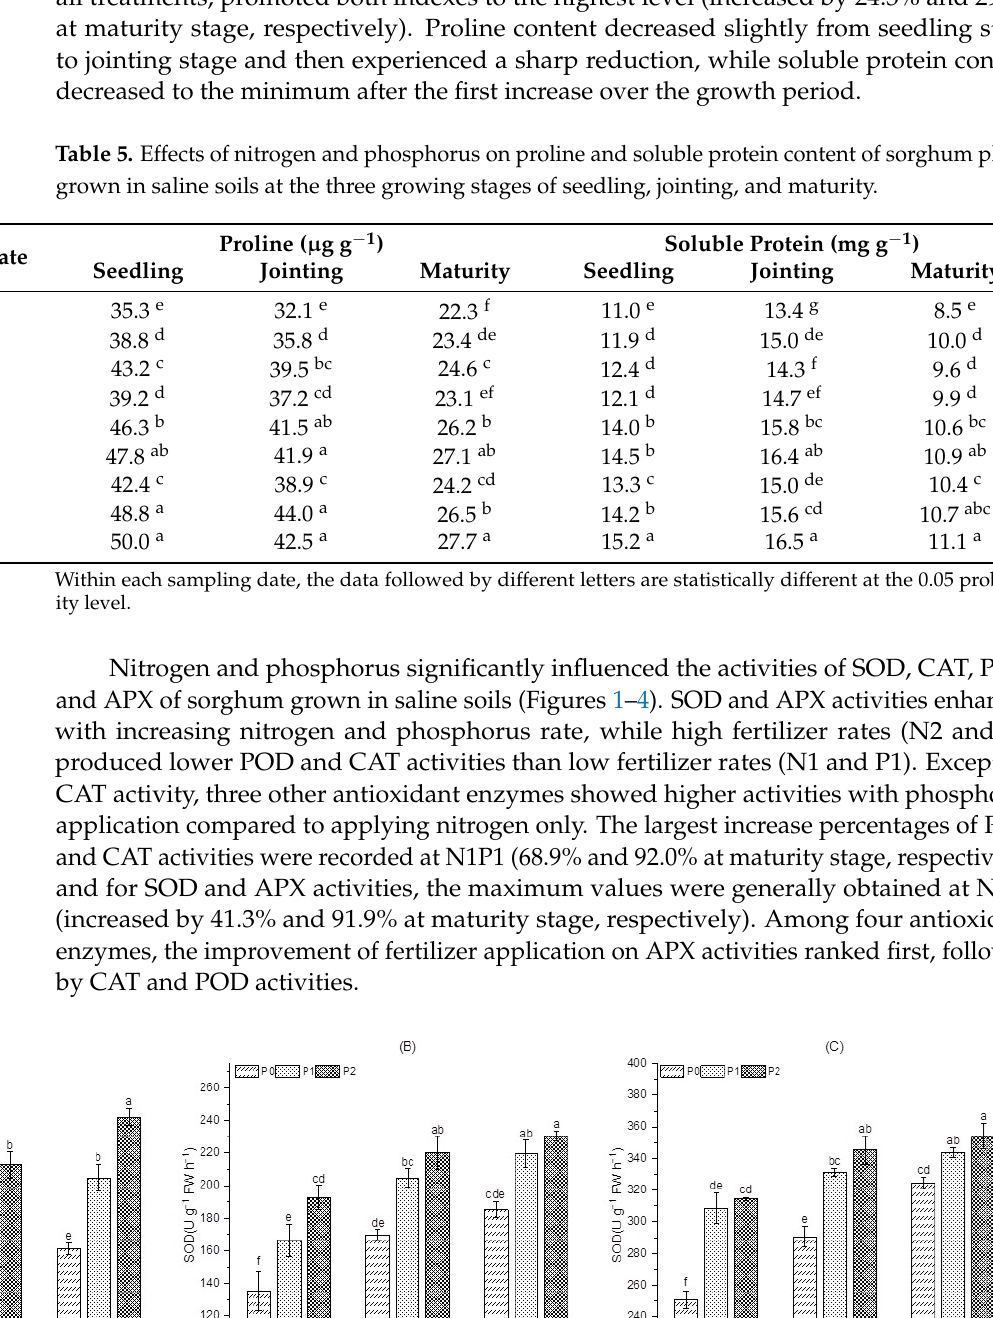
Figure 2. Effects of nitrogen and phosphorus on peroxidase (POD) activity of sorghum plants grown in saline soils at the three growing stages of seedling, jointing, and maturity. ( A ) Seedling stage; ( B ) Jointing stage; ( C ) Maturity stage. Within each sampling date, the data followed by different letters are statistically different at the 0.05 probability level. Figure 3. Effects of nitrogen and phosphorus on catalase (CAT) activity of sorghum plants grown in saline soils at the three growing stages of seedling, jointing, and maturity. ( A ) Seedling stage; ( B ) Jointing stage; ( C ) Maturity stage. Within each sampling date, the data followed by different letters are statistically different at the 0.05 probability level. According to Pearson correlation analysis, significant and positive correlations were observed within aerial biomass, height, stem diameter, proline and soluble protein con- tent, SOD, POD, CAT, and APX activities, as well as within MDA content, relative con- ductivity, O 2 − , and H 2 O 2 (Figure 5). Reversely, MDA, relative conductivity, O 2 − , and H 2 O 2 were negatively correlated with other characteristics. Among all correlations, stem